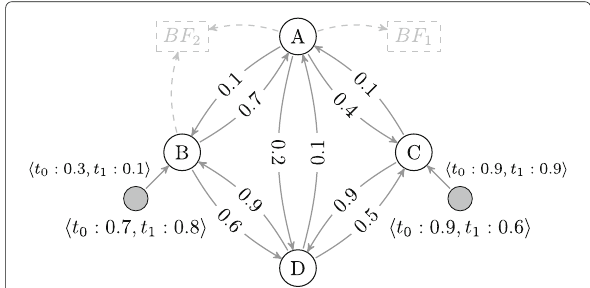
Fig. 2 A minimalistic resource dependency model. Conditional probability fragments are marked along the edges. Graynodes represent external shock events leading to local impacts on resources. Connections to the mission dependency model are sketched in